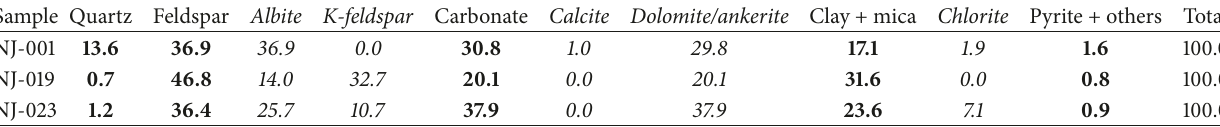
Table 3: XRD data of all investigated samples listing mineral groups (bold) and their corresponding minerals